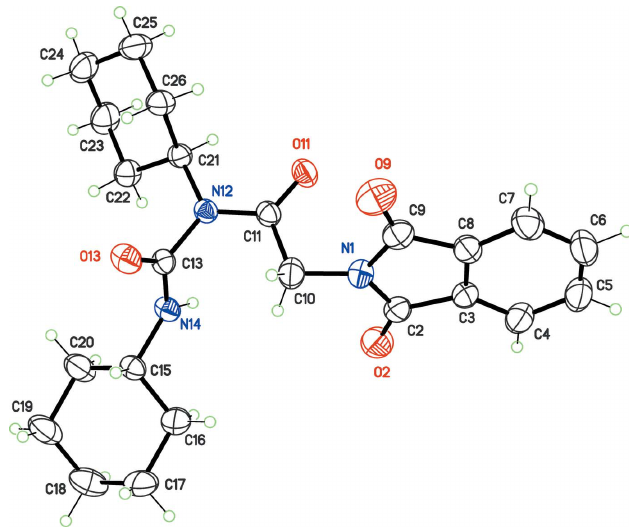
Figure 1 Molecular structure of the title compound, with displacement ellipsoids at the 30% probability